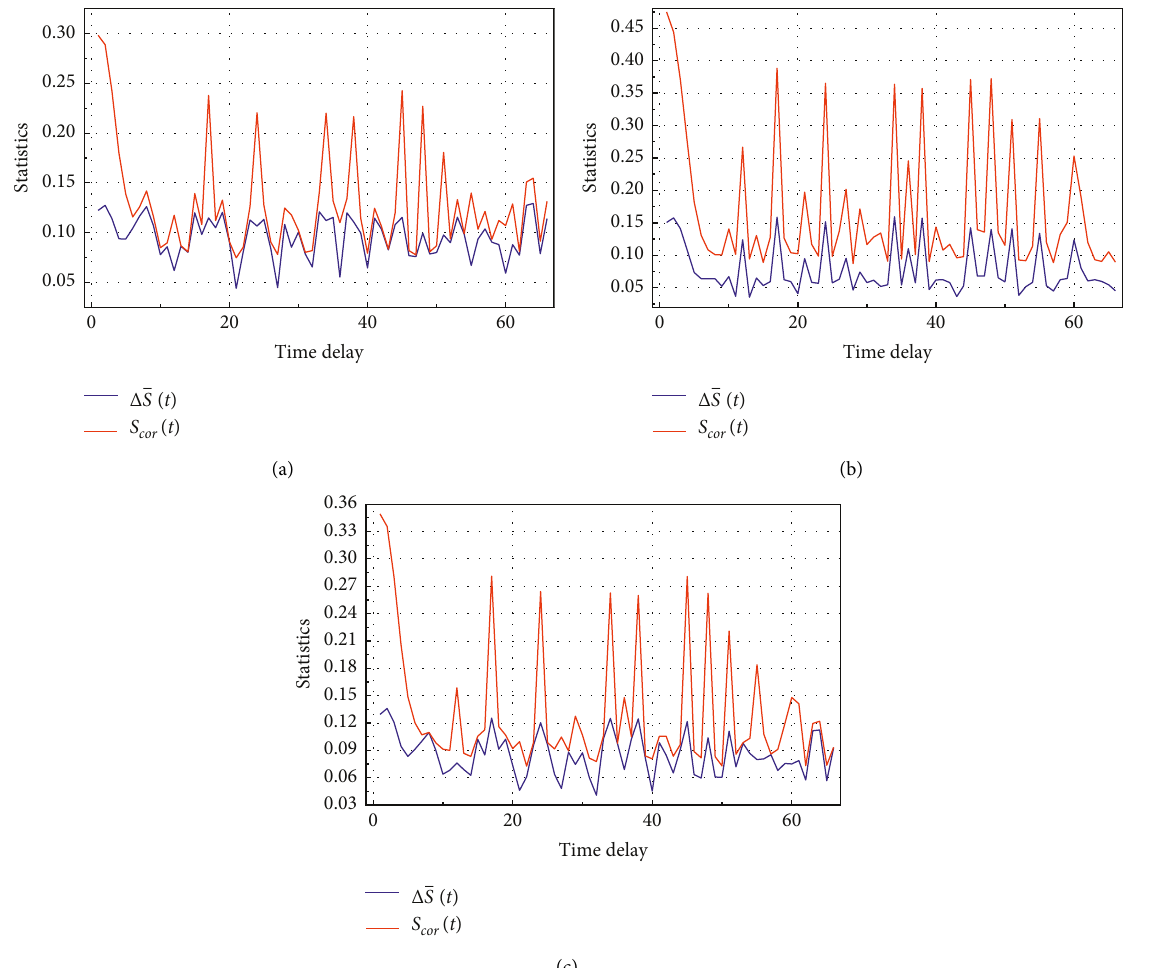
Figure 10: Experimental results of the C-C algorithm using the PeMSD8 dataset: (a) the L 2 norm measurement; (b) the infinite norm measurement method; and (c) the combined norm measurement.